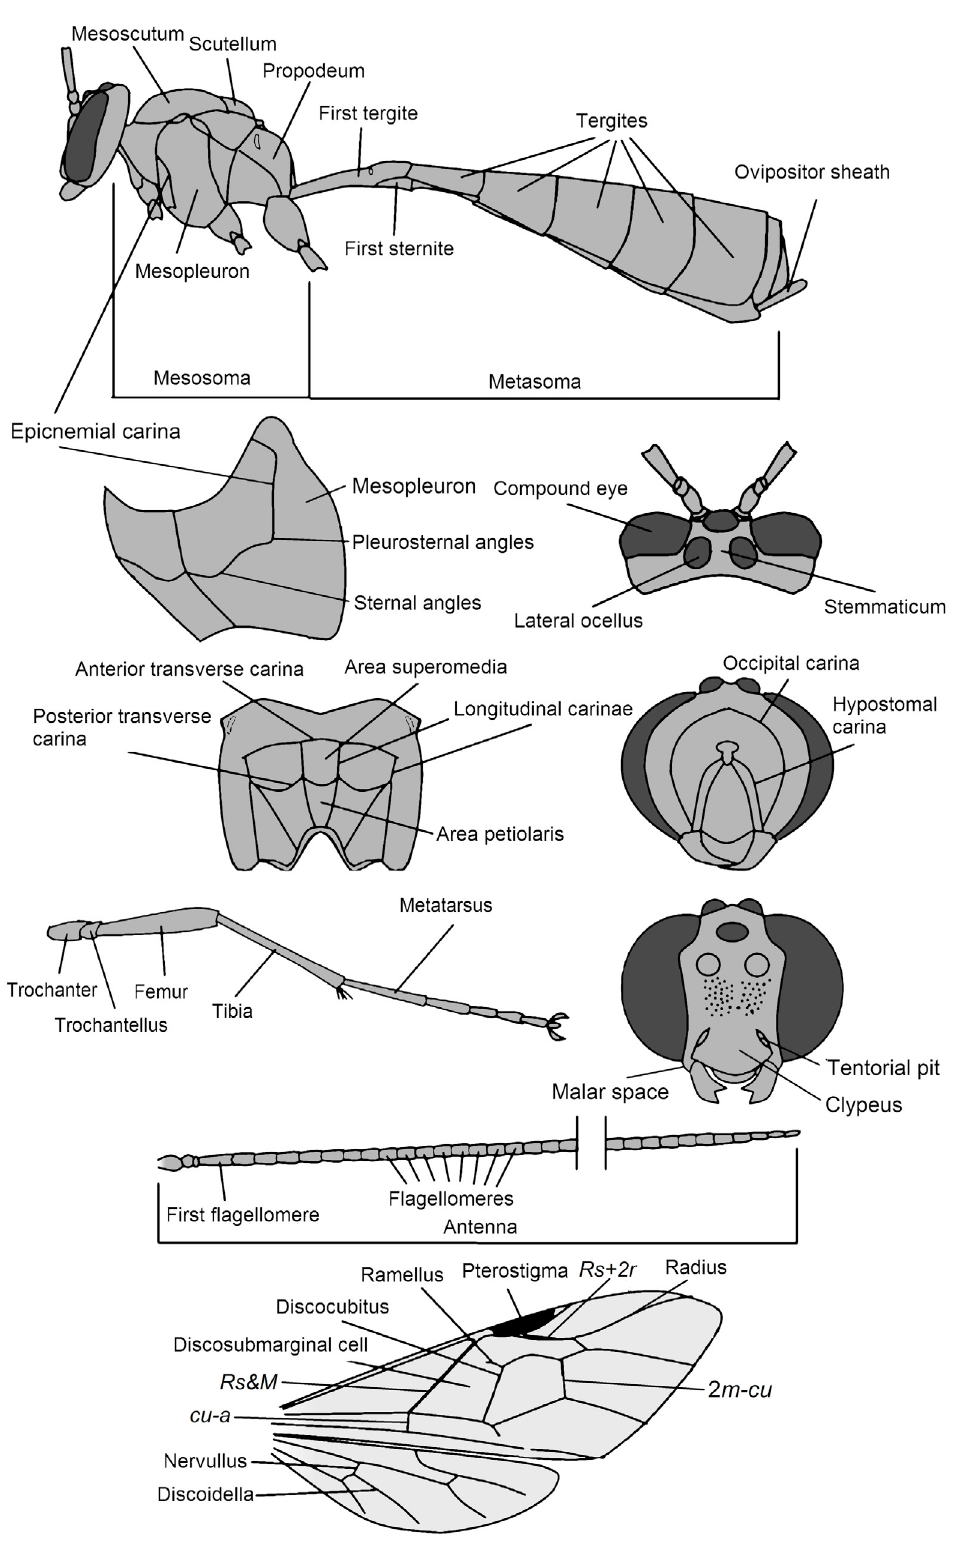
Fig. 2. Morphological terminology referred to in the